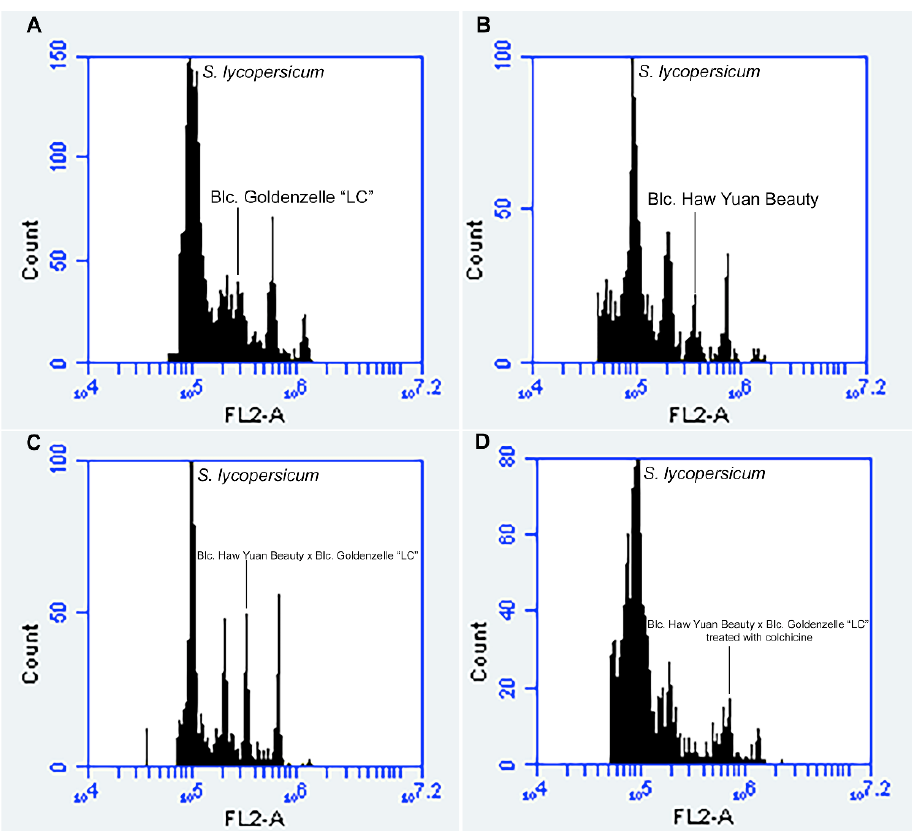
Figure 3. Flow cytometry histograms with nuclear 2C value measurements using the internal standard S. lycopersicum (2C = 2.00 pg): ( A ) male parent Blc. Goldenzelle “LC” with 2C = 5.79 pg; ( B ) female parent Blc . Haw Yuan Beauty with 2C = 7.79 pg; ( C ) Blc . Haw Yuan Beauty × Blc . Goldenzelle “LC” not treated with colchicine with 2C = 6.86 pg; ( D ) Blc. Haw Yuan Beauty × Blc. Goldenzelle “LC” treated with colchicine with 2C = 14.37 pg.